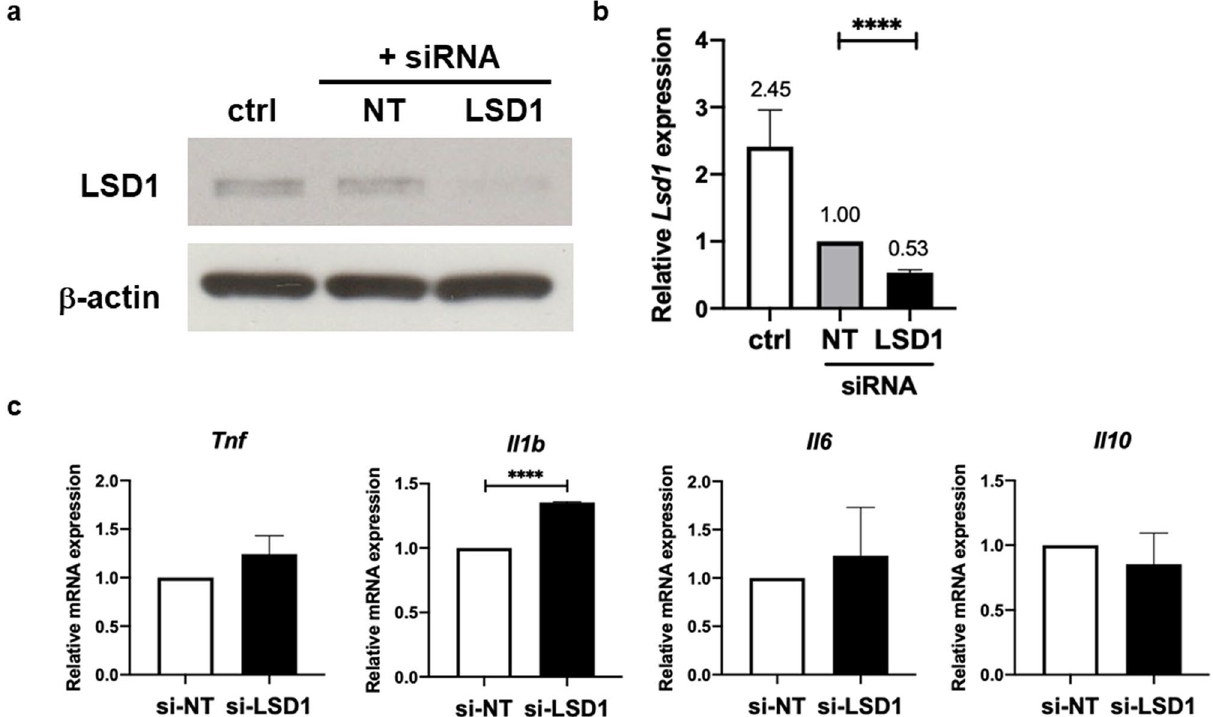
Figure 7. Effect of LSD1 silencing on LPS-tolerant macrophages. BMMs were transfected with 50 nM of siRNA lsd1 or Non-Target (NT) siRNA as described in “Materials and methods”. ( a , b ) Level of LSD1 at 48 h after siRNA transfection was detected by Western blot and qRT-PCR. ( c) Expression of pro-inflammatory and anti-inflammatory cytokines in lsd1 silencing LPS-tolerant macrophages at 6 h after LPS stimulation. *, **, *** and **** indicate significant differences compared by two-tailed unpaired t-test at p < 0.05, p < 0.01, p < 0.001 and p < 0.0001,